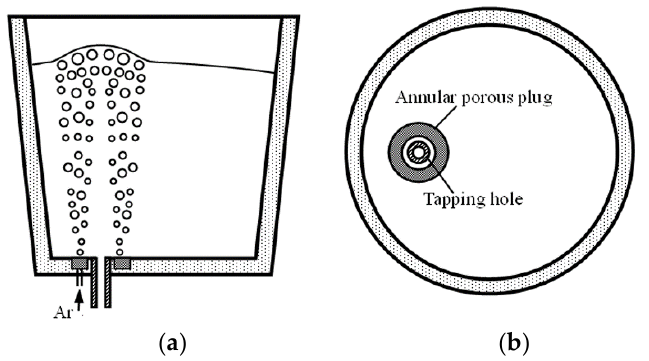
Figure 1. Schematic of the new controlling slag carry-over process with argon injected into the ladle around the tapping hole: ( a ) front view; and ( b ) top view.